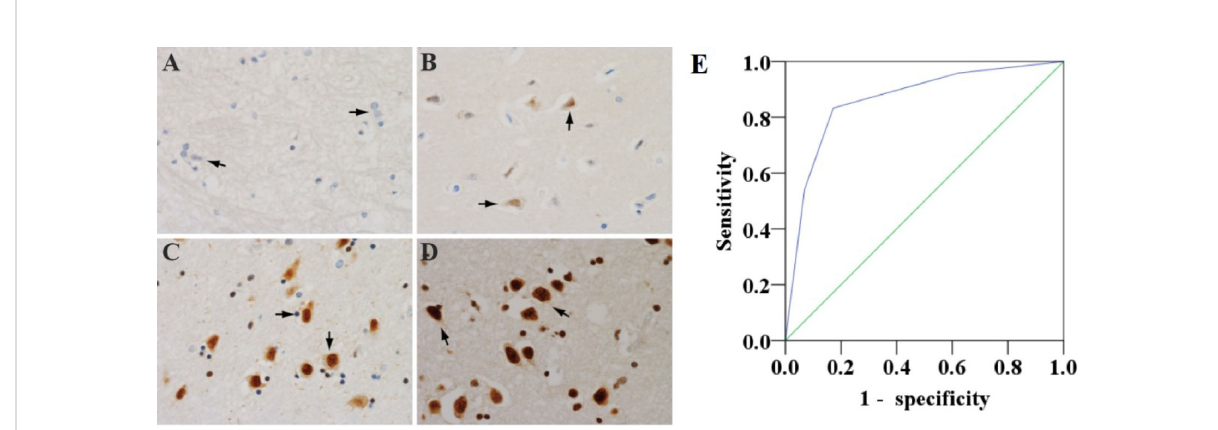
FIGURE 1 Four levels of Girdin expression in brain tissue neurons (×400). (A) Girdin has a low expression — brain tissue neuron Girdin does not stain. (B) The expression of Girdin is low, and the Girdin protein of neurons in brain tissue is stained with light yellow and the number is small. (C) Girdin is highly expressed. Girdin in brain tissue is stained yellow – brown, and the number is medium. (D) Girdin is highly expressed. Girdin in the brain tissue is stained in brown with a large number. The arrow refers to the neuron cell. (E) Receiver operating characteristic to evaluate the diagnostic signi fi cance of Girdin in DM patients, area under the curve = 0.863 (95% CI: 0.759 –